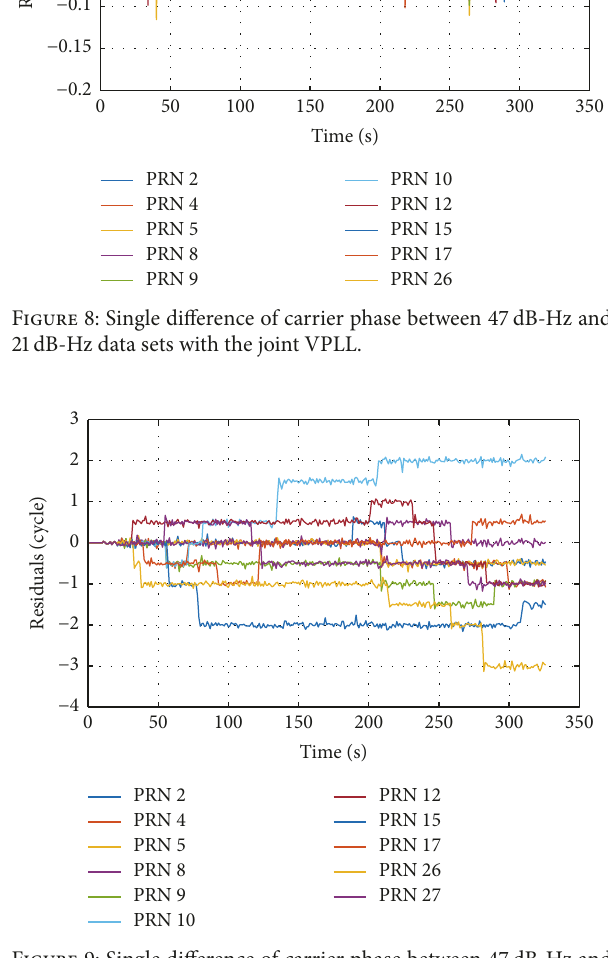
Figure 9: Single difference of carrier phase between 47 dB-Hz and 19 dB-Hz data sets with